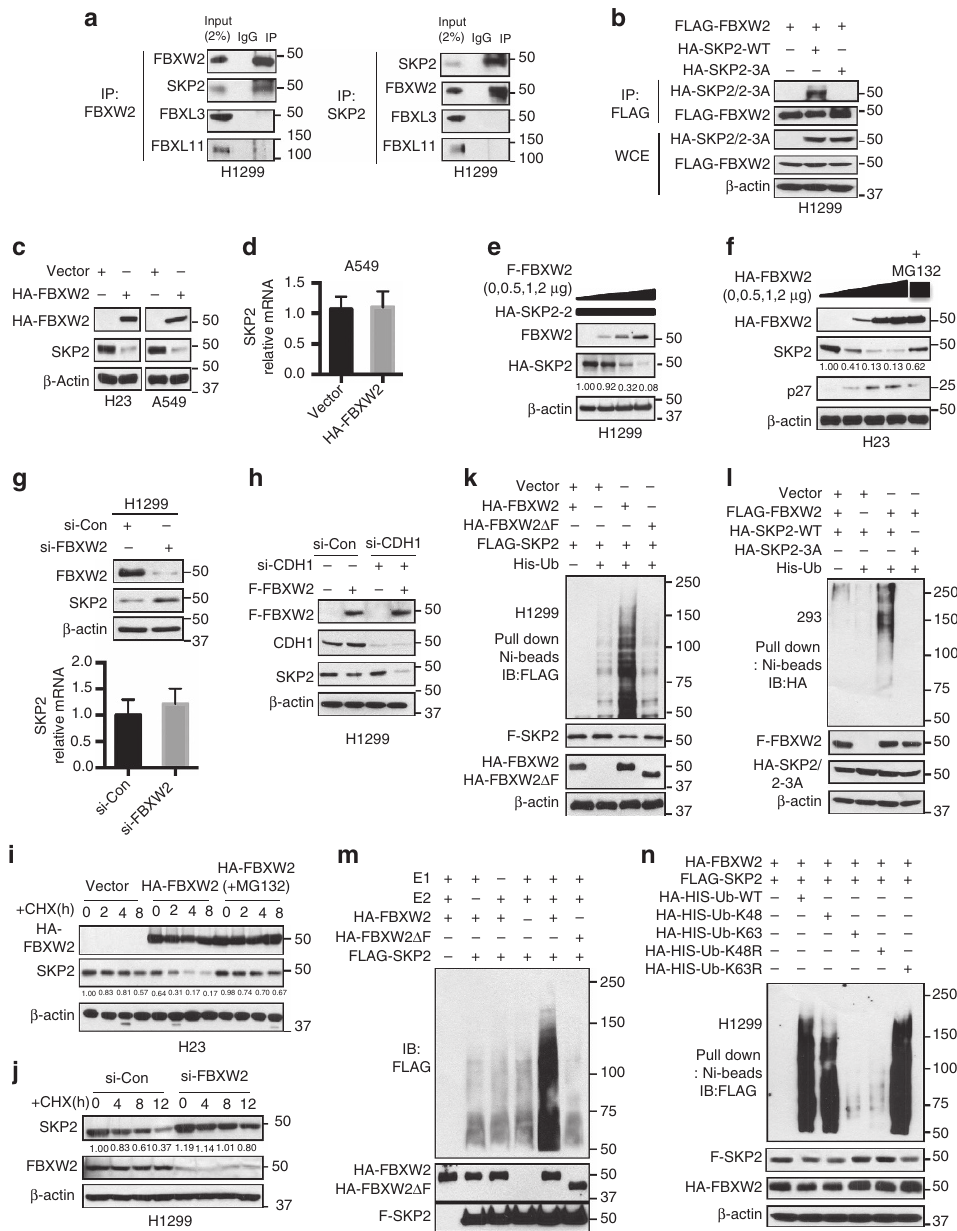
Figure 4 | FBXW2 binds to SKP2 and promotes its ubiquitylation and degradation. ( a ) FBXW2 binds to SKP2 in vivo : Lysates from H1299 cells were pulled down with anti-FBXW2 (left panel) or anti-SKP2 (right panel), followed by IB. ( b ) FBXW2 failed to bind to a SKP2 mutant: H1299 cells were tranfected with indicated plasmids, followed by FLAG IP and HA IB or direct IB. ( c , d ) Ectopically expressed FBXW2 reduces the endogenous levels of SKP2 protein, but not mRNA: Cells were transfected with HA-FBXW2, followed by IB ( c ) or qRT-PCR for SKP2 ( d ). Error bars indicate mean þ s.d. of three repeats. ( e , f ) FBXW2 overexpression decreases the levels of the exogenous and endogenous SKP2 proteins: Cells were co-transfected with indicated plasmids, followed by IB 48h post transfection. ( g ) FBXW2 depletion increases the levels of SKP2 protein, but not mRNA: Cells were transfected with FBXW2 siRNA and scramble siRNA, followed by IB or qRT-PCR for SKP2. Error bars indicate mean þ s.d. of three repeats. ( h ) FBXW2-induced SKP2 degradation is independent of CDH1: Cells were transfected with FLAG-FBXW2 and/or siRNA against CDH1, and then harvested for IB. ( i ) FBXW2 shortens SKP2 half-life: Cells were transfected with HA-FBXW2, and switched 48h post transfection to fresh medium containing CHX for indicated periods with or without MG132 treatment for last 2h, and then harvested for IB. The band density was quantified. ( j ) FBXW2 knockdown extends SKP2 half-life: Cells were transfected with siRNA targeting FBXW2. Cells were switched 48h later to fresh medium containing CHX for indicated periods and harvested for IB. The band density was quantified. ( k , l ) FBXW2 promotes ubiquitylation of SKP2 ( k ), but not SKP2-3A mutant ( l ): Cells were transfected with indicated plasmids, followed by Ni-beads pull-down and IB for SKP2. ( m ) FBXW2 promotes SKP2 ubiquitylation by in vitro assay: H1299 cells were transfected with indicated plasmids. Pull-down purified FBXW2 and FBXW2 D F (E3s), Pull-down purified SKP2 (substrate), were added into a reaction mixture containing ATP, ubiquitin, E1 and E2, followed by IB using anti-FLAG Ab. ( n ) FBXW2 promotes SKP2 ubiquitylation via K48 linkage: Cells were transfected with indicated plasmids, lysed under denatured condition at 6M guanidinium solution, followed by Ni-beads pull-down and IB for